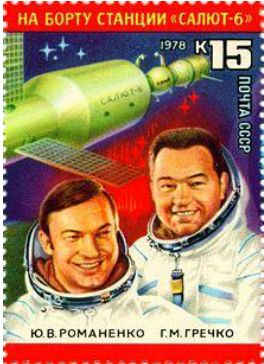
Figure 6. The soviet cosmonaut Yury Viktorovich Romanenko tested the utilization of Chlorella as an ideal food in long space journeys.